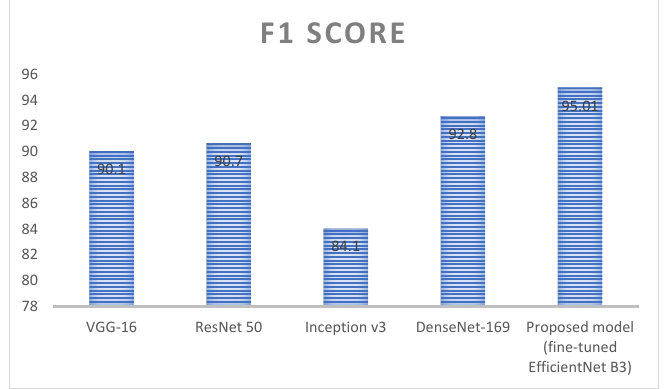
Figure 15. Analysis of F1 score value for the deep learning algorithms.